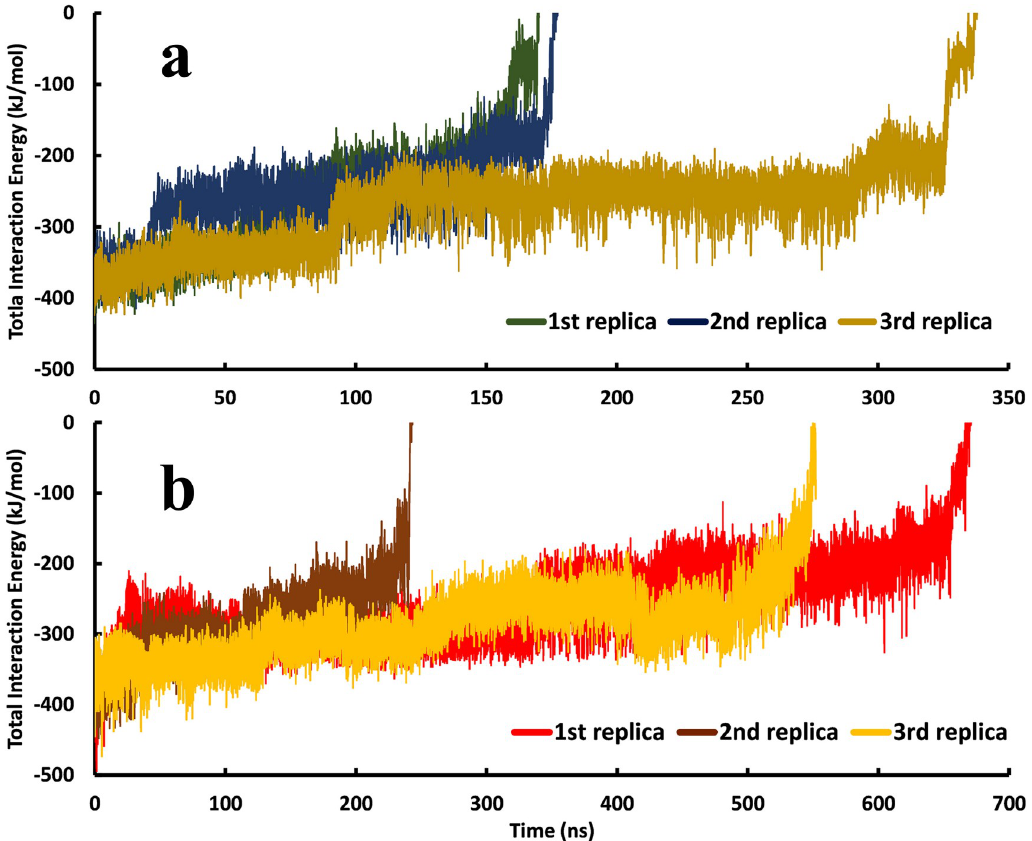
Fig 4. The total interaction energies of Indinavir in the unbinding pathways in the three series of replicas for each protein- ligand complex. a, Indinavir-HIV protease complex. b, Indinavir-HTLV-1 protease complex.